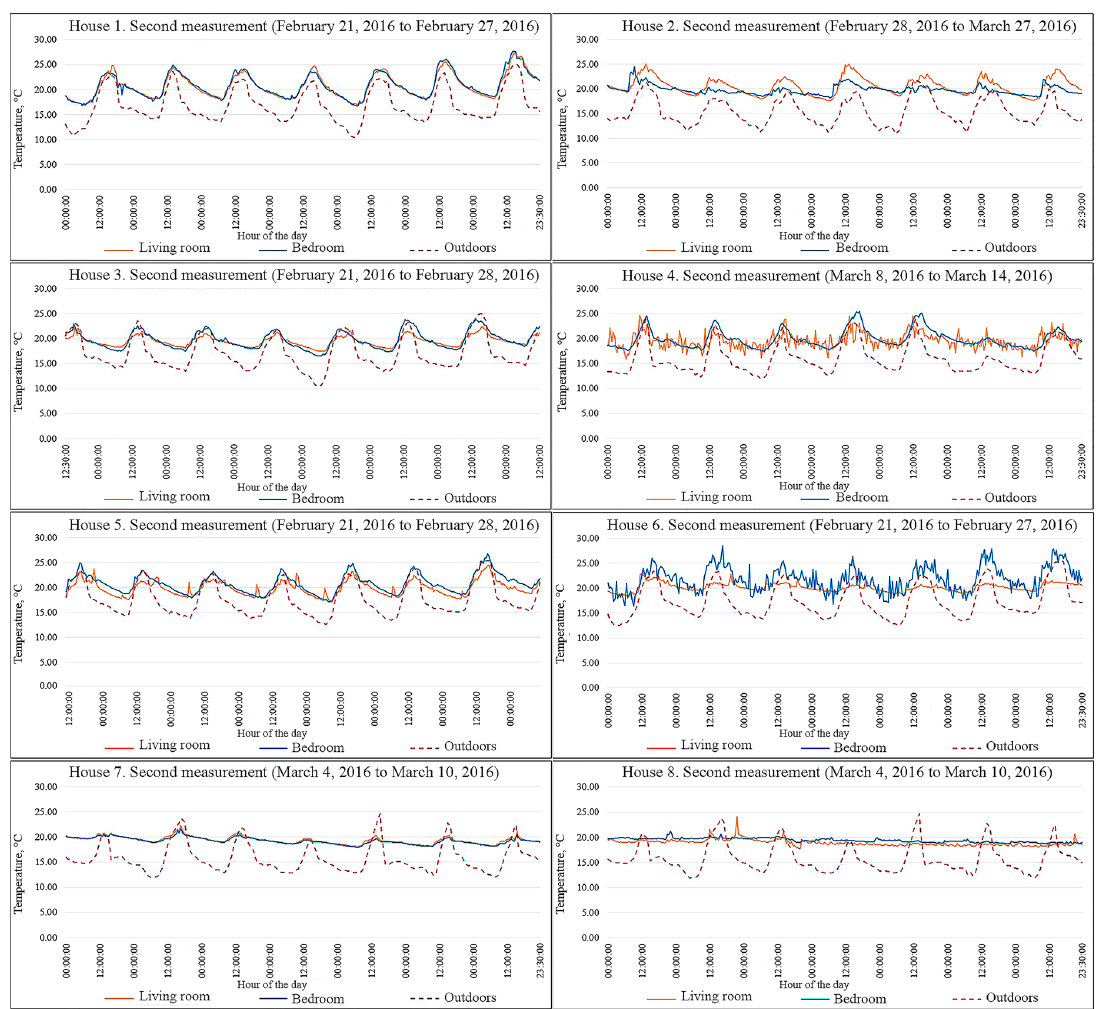
Figure 5. Operative and external temperature measurements (includes all studied cases) during the second monitoring of the warm period in February. Data from: Environmental